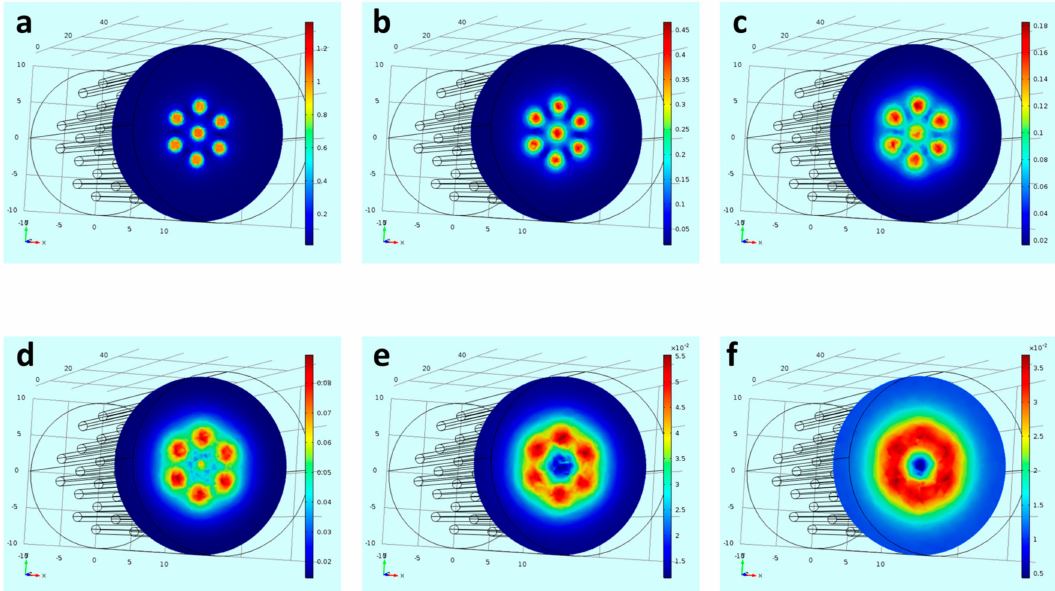
Figure 4. Simulated magnetic flux density ( a ) 0.1 mm from top ( b ) 0.5 mm from top ( c ) 1 mm from top